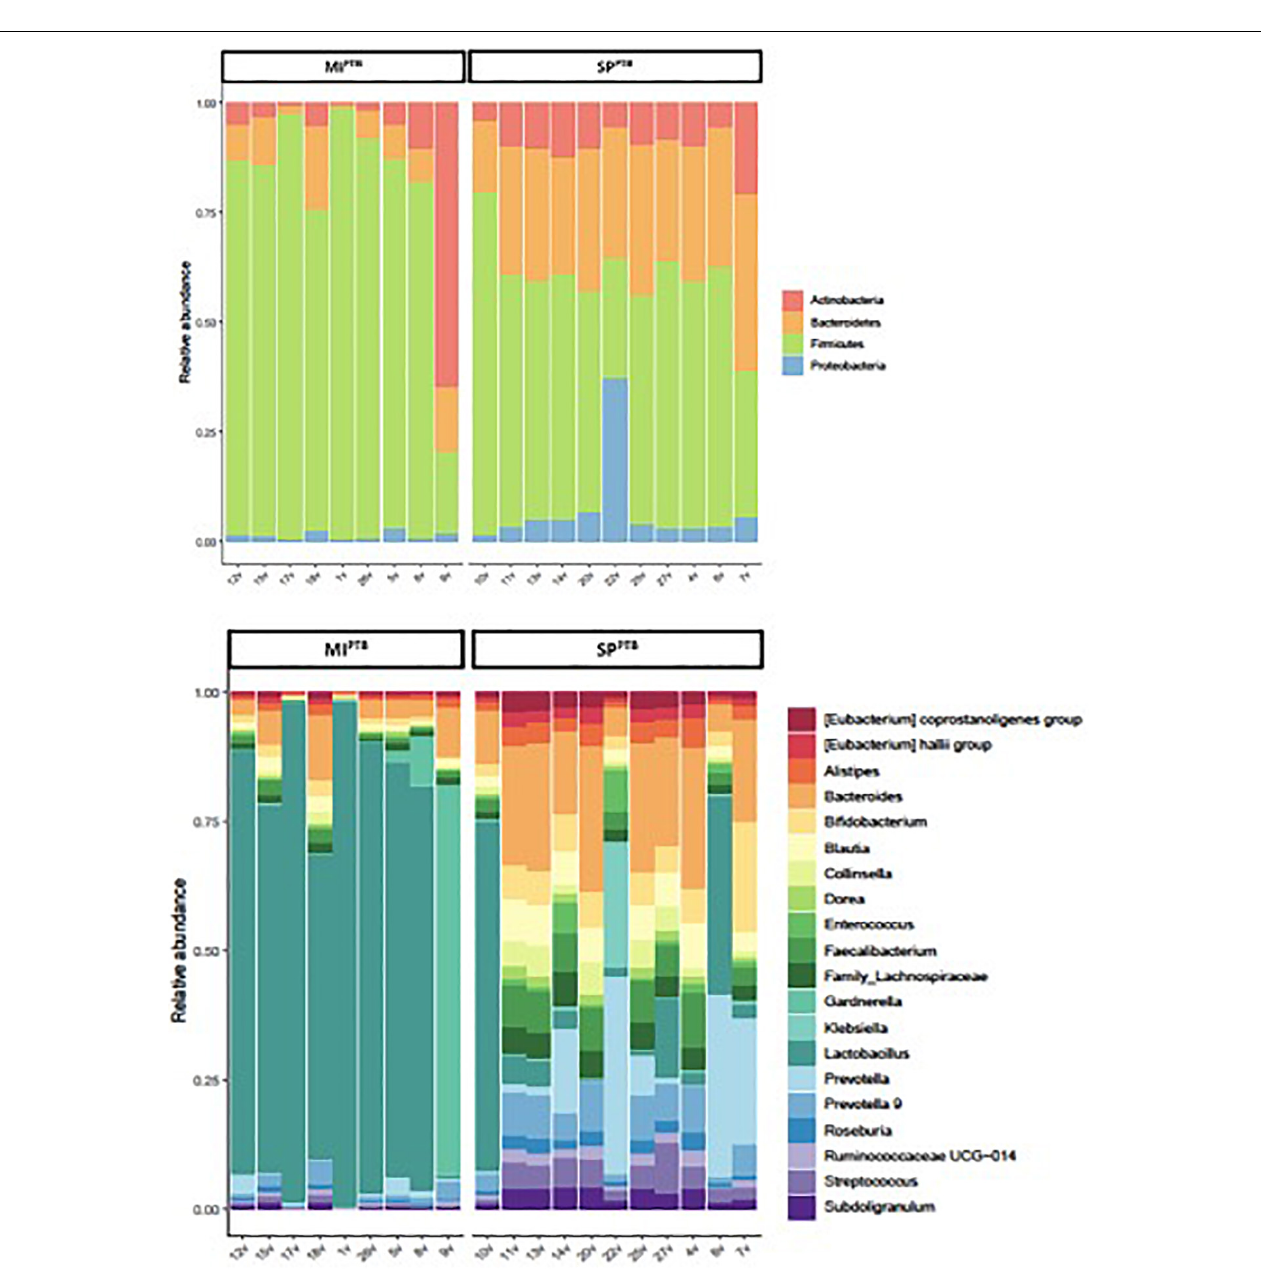
FIGURE 7 | Relative abundances of bacterial taxa composing the newborns’ mothers vaginal flora, classified on the basis of preterm birth type (MI PTB and SP PTB ). For MI PTB and SP PTB groups, proportions for major phyla (A) and major genera (B) were computed, normalized, and presented as stacked bar plots, respectively. The statistical significance at a P -value of ≤ 0.05 was assessed using the Mann–Whitney U